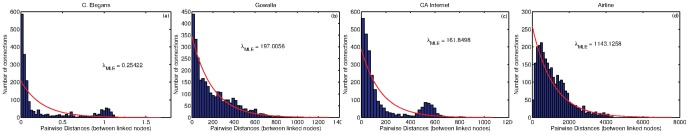
Distribution of the pairwise distances between linked nodes along with a maximum likelihood fit to an exponential distribution.